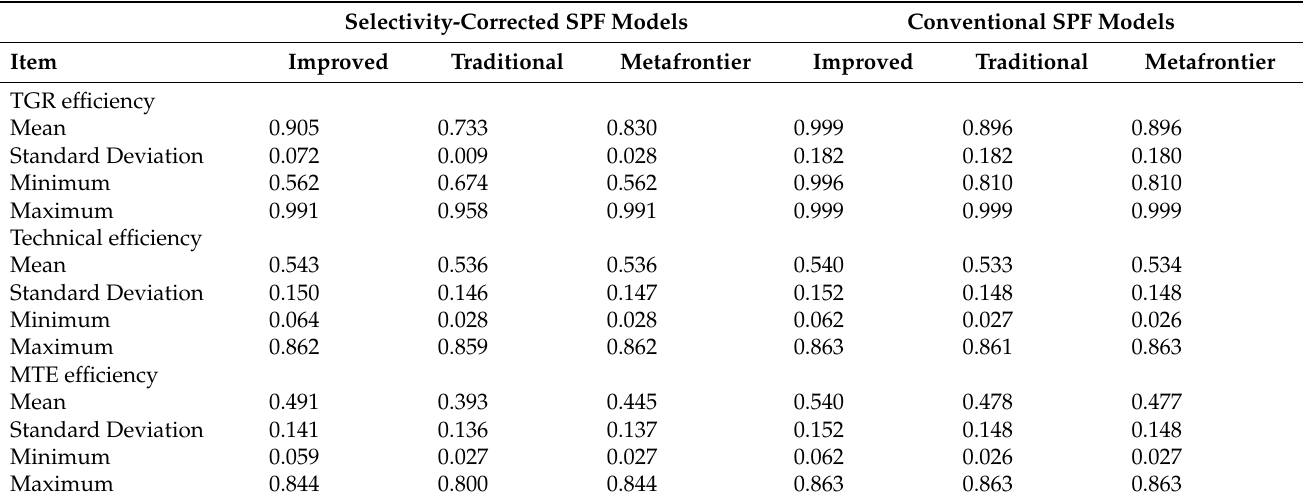
Table 6. Descriptive statistic of technical efficiency estimates for matched